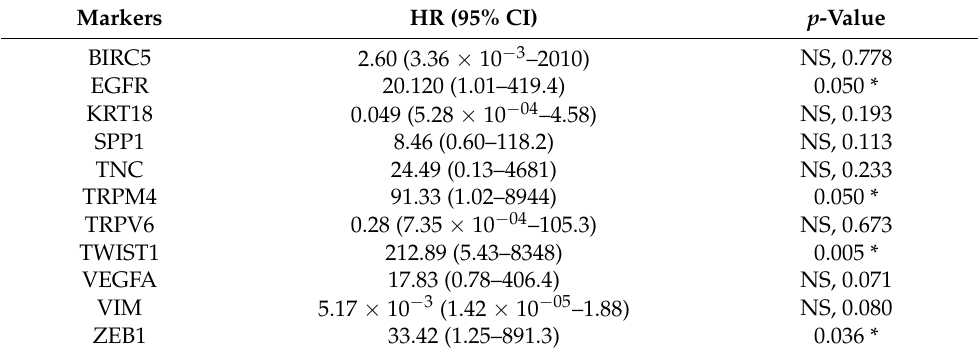
Table 3. The univariate Cox regression analysis of the selected biomarkers and